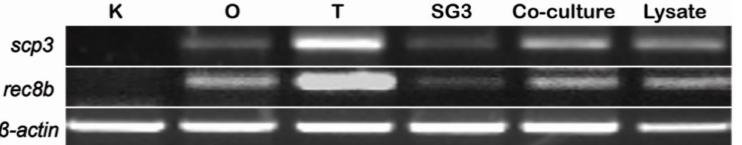
Figure 7. Meiotic gene expression in vitro . Expression of meiotic genes by RT-PCR with primers for scp3 and rec8b . Expression of scp3 and rec8b transcripts is low in undifferentiated SG3 cells. Elevated expression of both genes is observed in SG3 cells under induction culture conditions. K, head kidney; O, ovary; T,